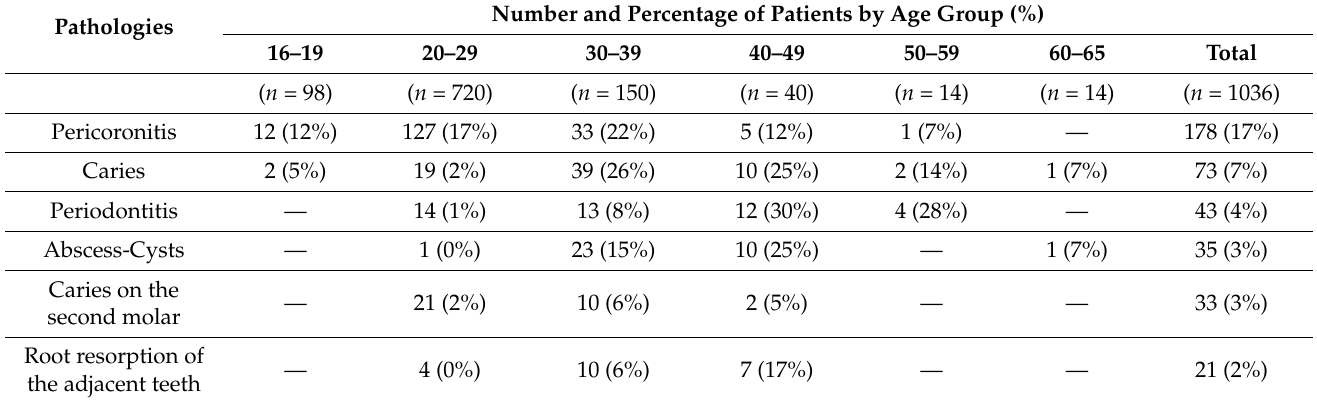
Table 6. Distribution of pathologies occurring in third molars according to